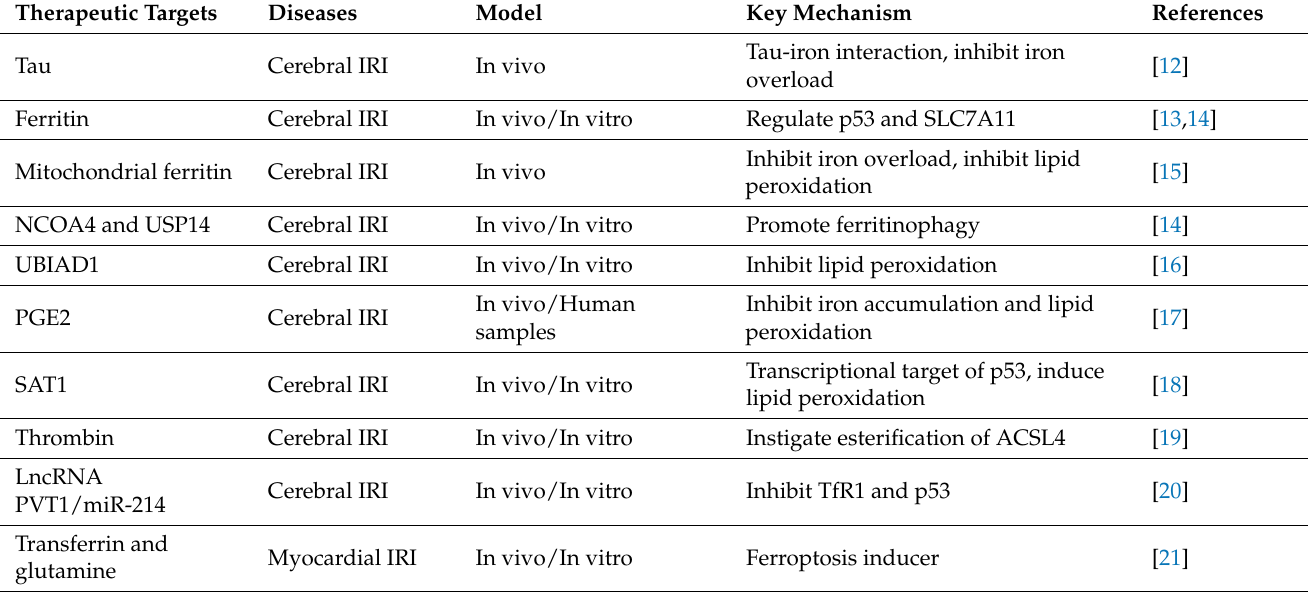
Table 1. Therapeutic targets of ferroptosis in ischemia-reperfusion